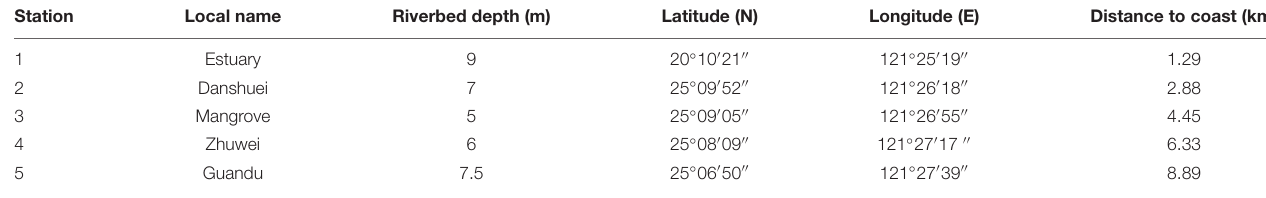
TABLE 1 | Local name, riverbed depth (m), coordinates, and distance to coast (km) of five sampling stations in the estuarine area of the Danshuei River.